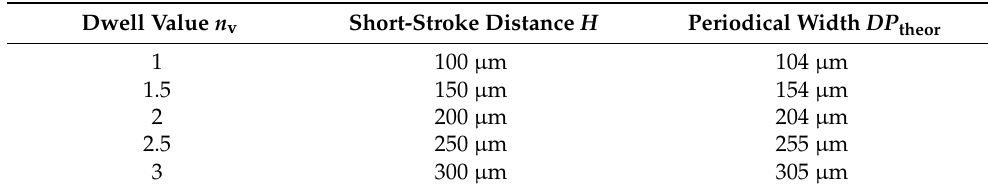
Table 3. Variable machining parameters: dwell value, the resulting setting value for the short-stroke distance and the periodical width of the surface